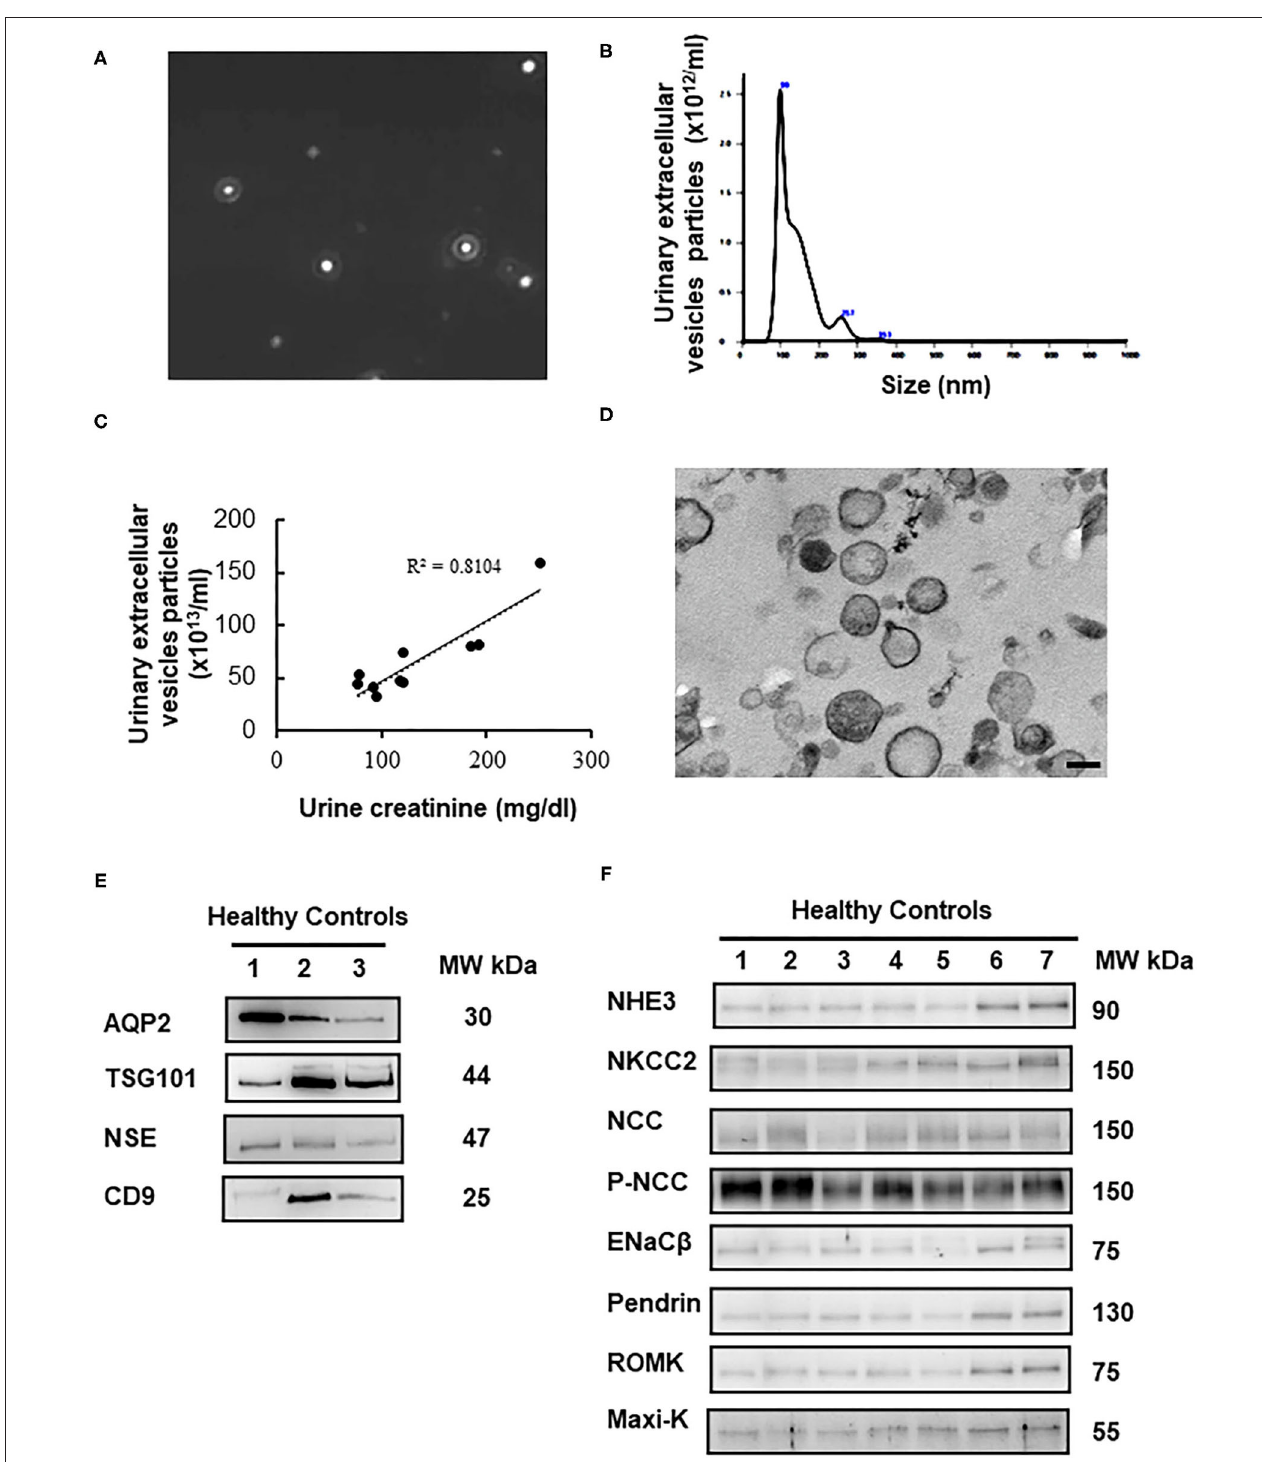
FIGURE 1 | Characterization of urinary extracellular vesicles (uEVs) from healthy controls. (A) Screen shot from 1:2,000 diluted urine sample reveals a range of particle sizes by nanoparticle tracking analysis (NTA). (B) Concentration and size distribution of uEVs (0–150nm diameter) by NTA were shown. The concentration is expressed as number of particles per ml. (C) uEVs particles were correlated strongly with urine creatinine ( r 2 for 0.81, P < 0.0001). (D) Transmission electron microscopy of uEVs was shown (scale bar 100nm). (E) uEVs markers (AQP2, TSG101, NSE, and CD9) were assessed by immunoblotting. (F) Expression pattern of renal transporters including NHE3, NKCC2, NCC, p-NCC, ENaC β , pendrin, ROMK, and Maxi-K from healthy controls was similar.